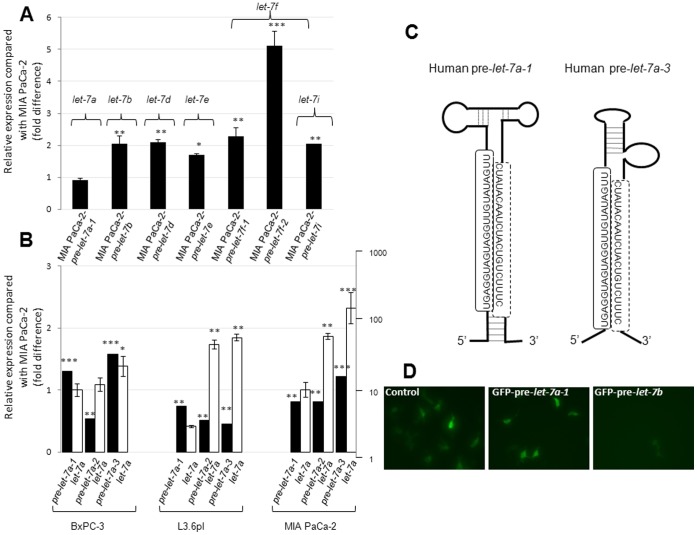
Defective processing of pre-let-7a-1, but not pre-let-7a-3, into let-7a in MIA PaCa-2.
A, Relative expression of mature forms of let-7 in MIA PaCa-2 stably expressing pre-let-7 family members. Columns, mean of triplicate; bars, SD. n = 3. B, Relative expression of precursor (filled bars; right axis) and mature (open bars; left axis) let-7 forms in pancreatic cancer cells transiently expressing let-7a precursors. Columns, mean of triplicate; bars, SD. n = 3. C, Schematic representation of the structures of pre-let-7a-1 and pre-let-7a-3. Sequences of mature and passenger let-7a strands within the precursors are boxed in continuous or broken lines, respectively. D, Lack of complete cleavage of pre-let-7a-1-GFP mRNA in MIA PaCa-2 cells. MIA PaCa-2 cells were transiently transfected with either pmirGLO-G-Fud (control), pmirGLO-GFP-pre-let-7a-1, or pre-pmirGLO-GFP-pre-let-7b constructs, and GFP fluorescence was captured. Original magnification, x20. *p<0.05, **p<0.01, ***p<0.001.